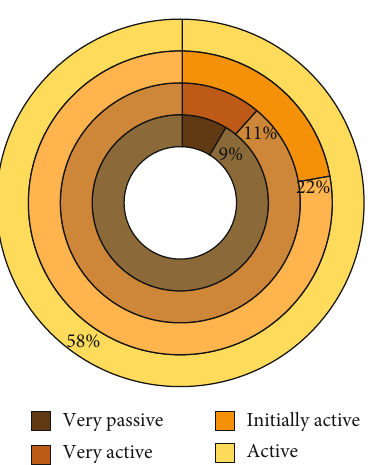
Figure 2: Attitudes of college students ’ participation in labor